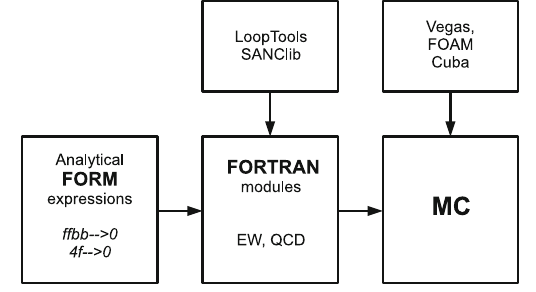
Fig. 39 The SANC framework